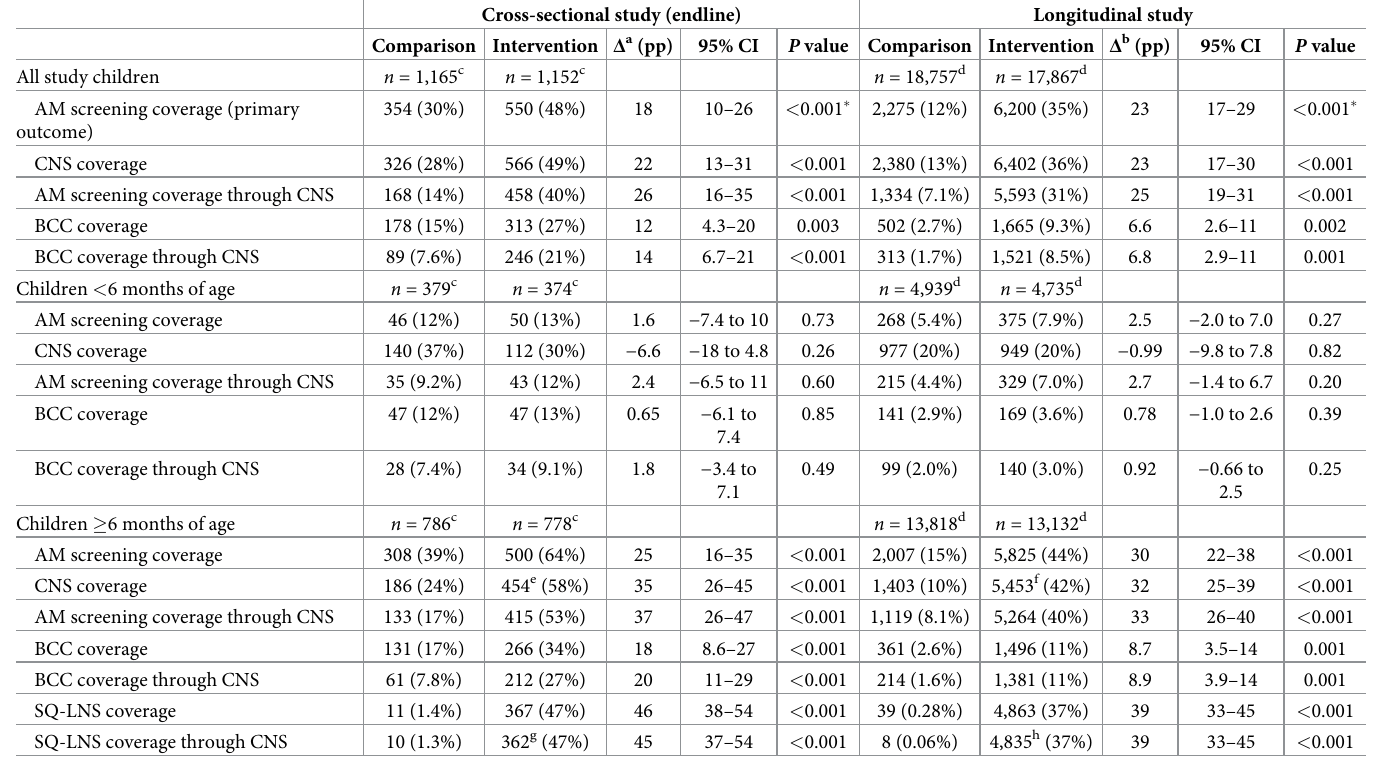
Table 3. Effect of intervention on coverages of AM screening, BCC, and SQ-LNSs in the past month assessed by cross-sectional and longitudinal